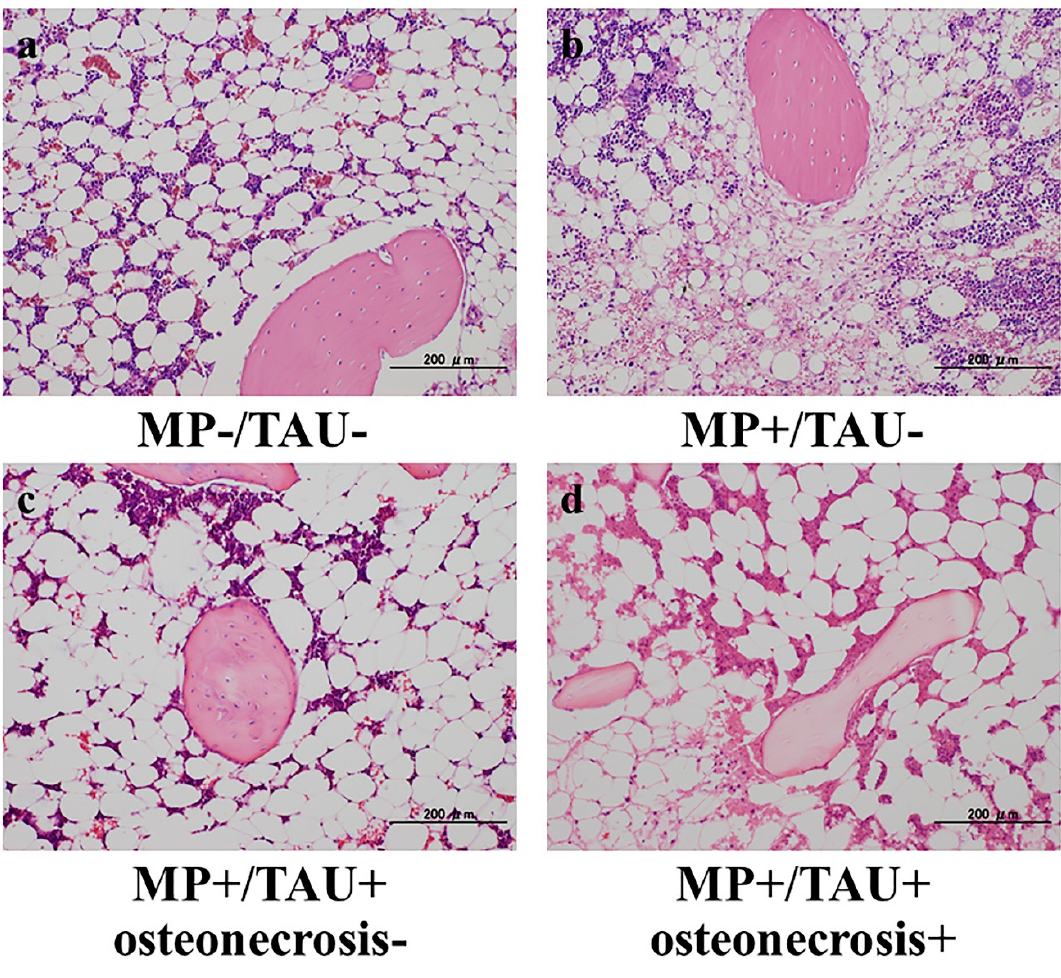
Figure 2. Osteonecrosis inhibition with intravenous administration of taurine in a glucocorticoid-induced rabbit osteonecrosis model. ( a ) MP − / TAU − , ( b ) MP +/ TAU − , ( c , d ) MP +/ TAU + . Osteonecrosis was found in 12 of 15 rabbits of MP +/ TAU − group ( b ). In 4 of 15 rabbits of the MP +/ TAU + group, some portions showing necrosis of medullary haematopoietic cells or fat cells and empty lacunae or condensed nuclei in osteocytes were found ( d ). The osteonecrosis development rate was 20%, representing a significant inhibition of osteonecrosis as compared with the MP +/ TAU − group ( p < 0.05). Scale bar: 200 µm.